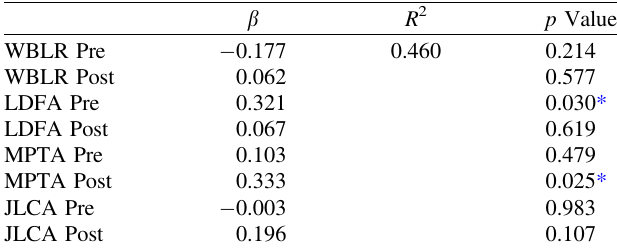
Table 3. Multiple linear regression analysis of factors associated with joint line obliquity after OWHTO.